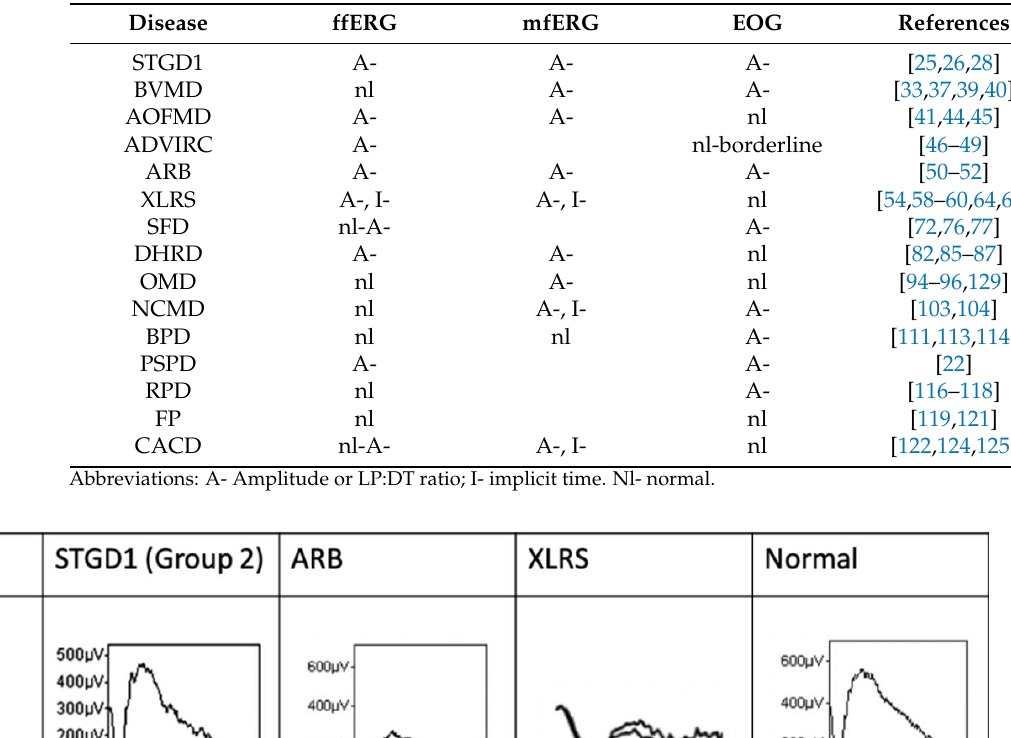
Table 2. Electrophysiology findings in macular dystrophies.